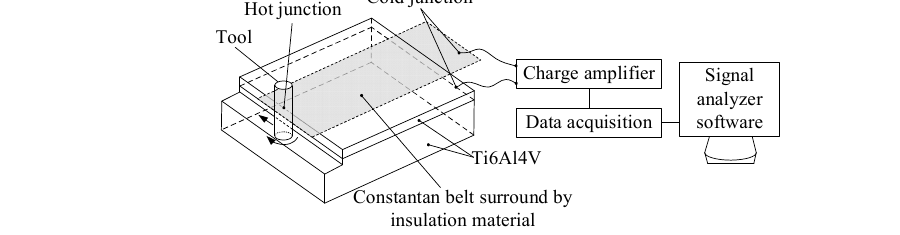
Figure 14. A schematic of semi-artificial thermocouple temperature measurement device.